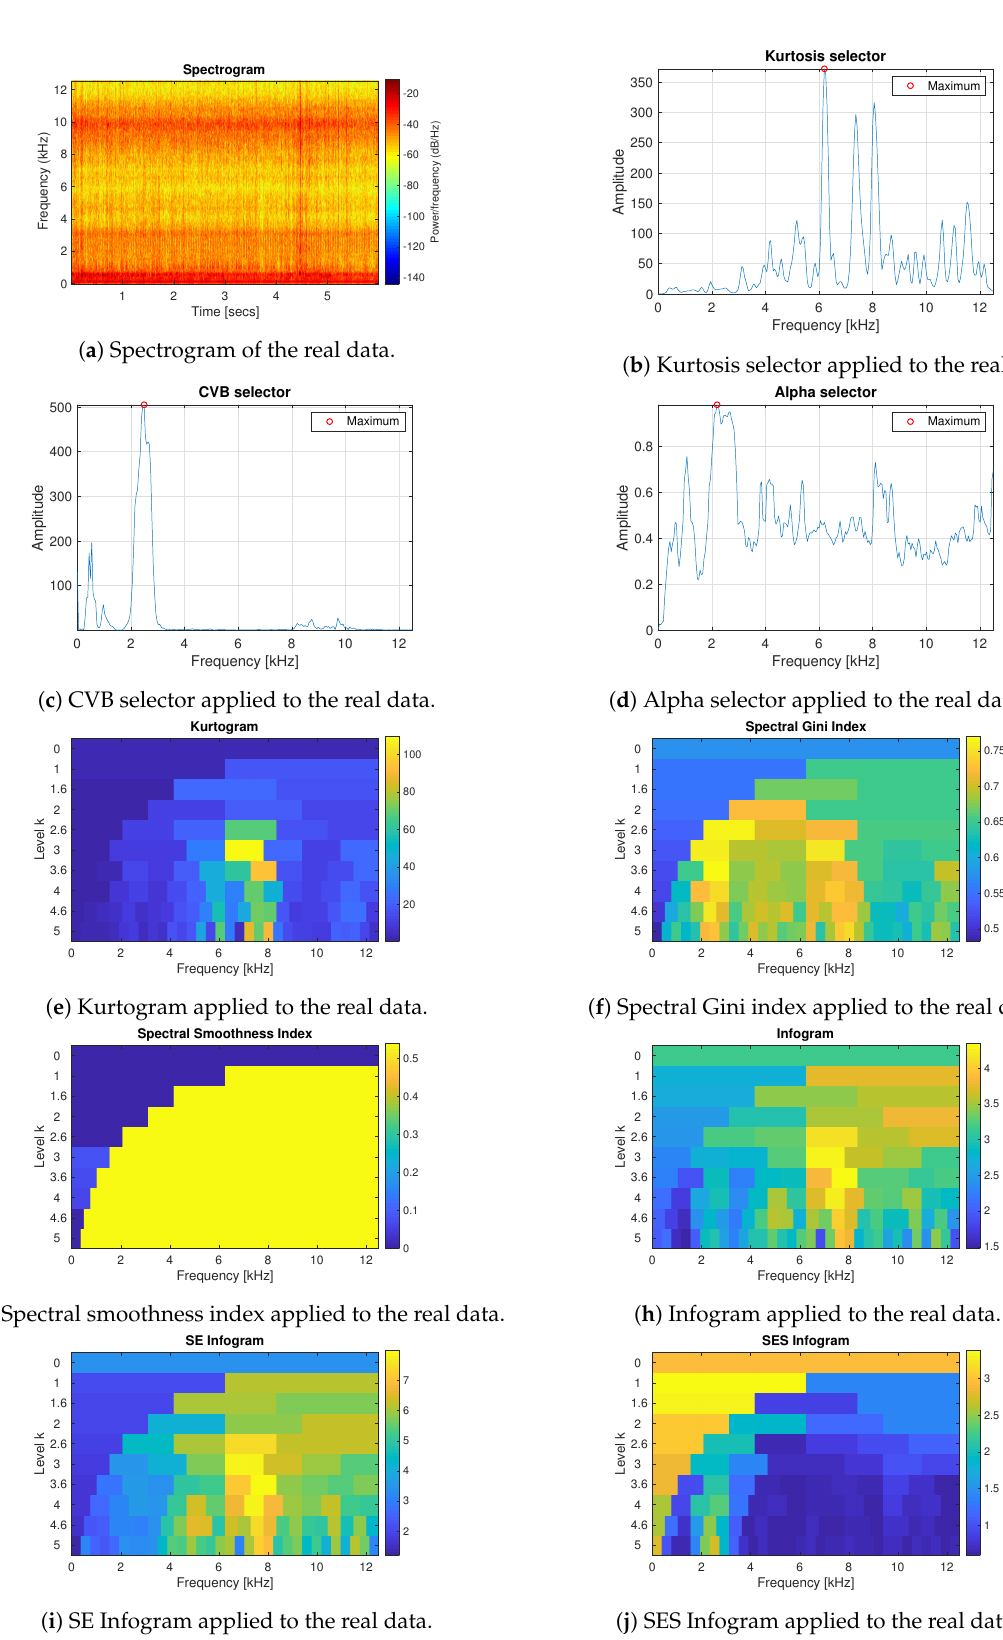
Figure 8. Results of the informative frequency band selection for 7 different methods for the real data from the bearing of the crushing